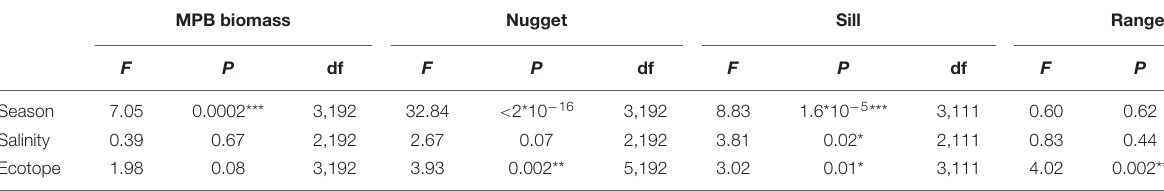
TABLE 4 | Statistics of MPB biomass and semi-variogram parameters calculated per ecotope.